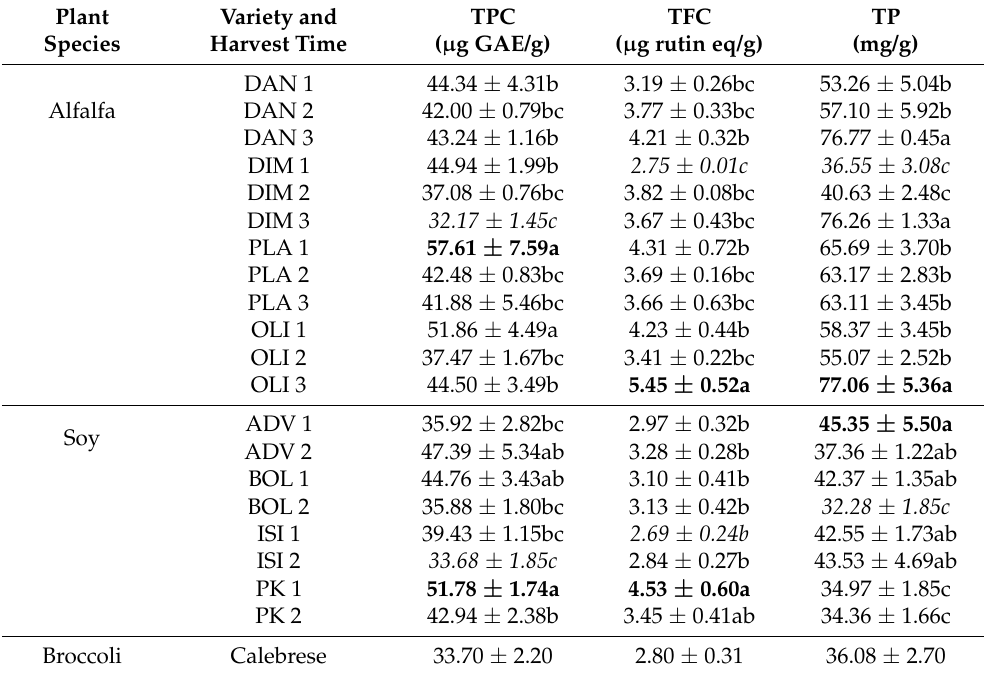
Table 1. Total phenol content (TPC), total flavonoid content (TFC) and total protein (TP) in pressed fibre from different plants and